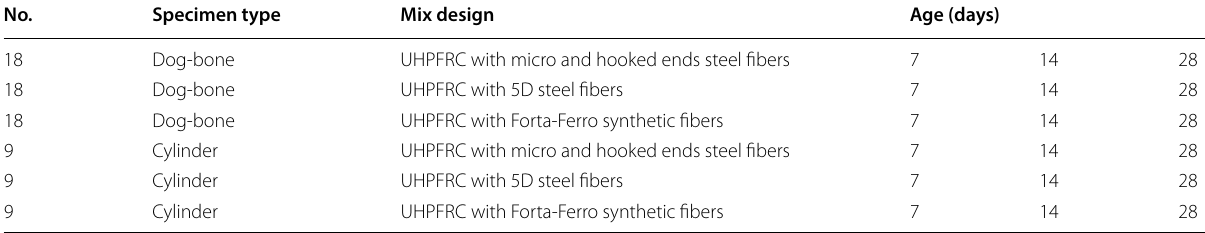
Table 2 Uniaxial tensile and compressive tests specimens